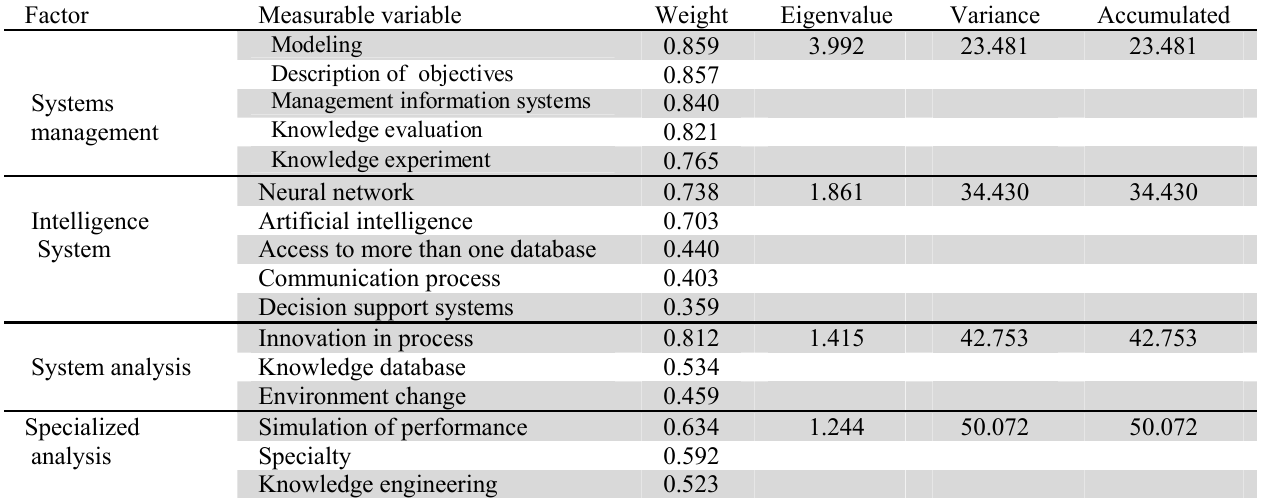
The summary of factor